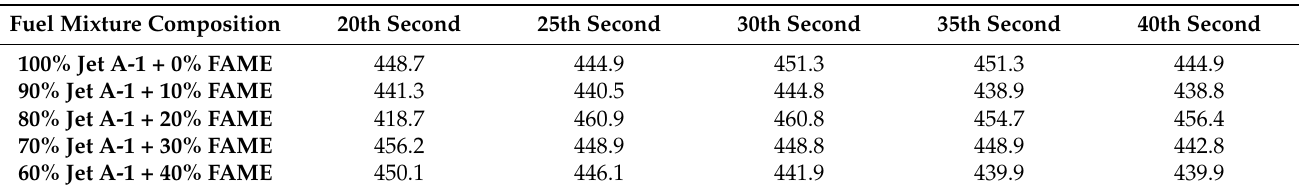
Figure 16. The graphical course of SJE-20 thrust F .T. [N] changes when using different mixtures of Jet A-1 aviation kerosene and FAME biofuel. Table 21. Change in thrust F .T. [N] with different concentrations of Jet A-1 aviation kerosene and FAME biofuel.